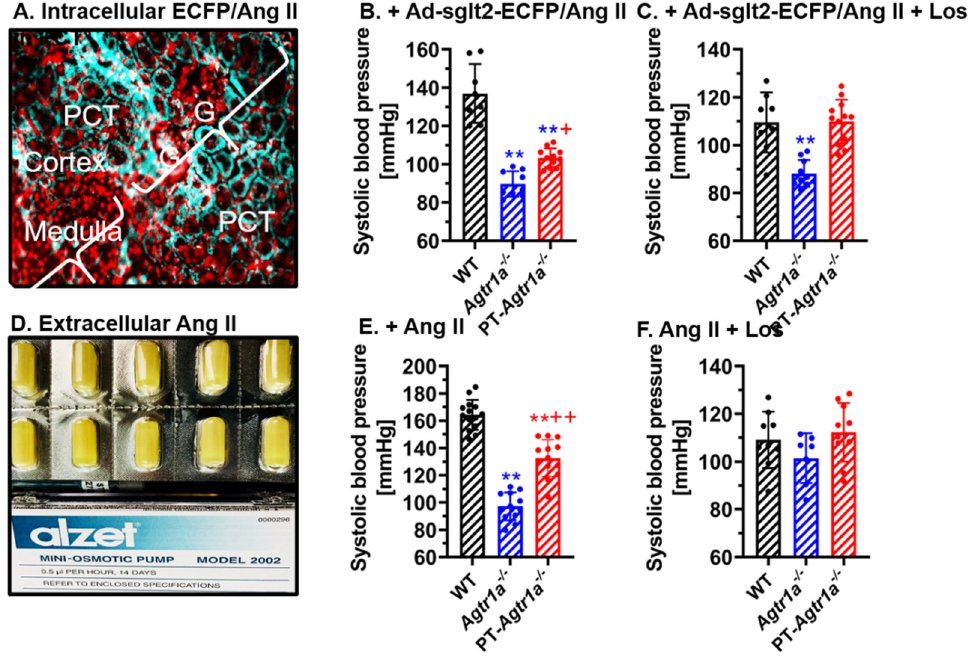
Figure 3. Angiotensin II-induced hypertension by adenovirus-mediated, sglt2 promoter-driven proximal tubule-specific overexpression of an intracellular Ang II fusion protein Ad-sglt2-ECFP/Ang II in the kidney ( A – C ), or osmotic minipump infusion of a pressor dose of Ang II ( D – F ) in wild-type mice was significantly attenuated in proximal tubule-specific PT- Agtr1a -/- mice. In response to proximal tubule-specific overexpression of Ad-sglt2-ECFP/Ang II, blood pressure was elevated by 17 ± 3 mmHg in wild-type mice, and the increase was totally blocked in PT- Agtr1a -/- mice ( B ). Infusion of a high pressor dose of Ang II for 2 weeks (1.5 mg/kg/day, i.p.) markedly increased blood pressure by >45 mmHg in wild-type mice, and this increase was attenuated by half in PT- Agtr1a -/- mice ( E ). Concurrent treatment with the AT 1 receptor blocker losartan (20 mg/kg/day, p.o.) normalized blood pressure to the wild-type control levels. ** p < 0.01 vs. wild type; + p < 0.05 or ++ p < 0.01 vs. Agtr1a -/- mice. Reproduced from Reference [28] with permission.